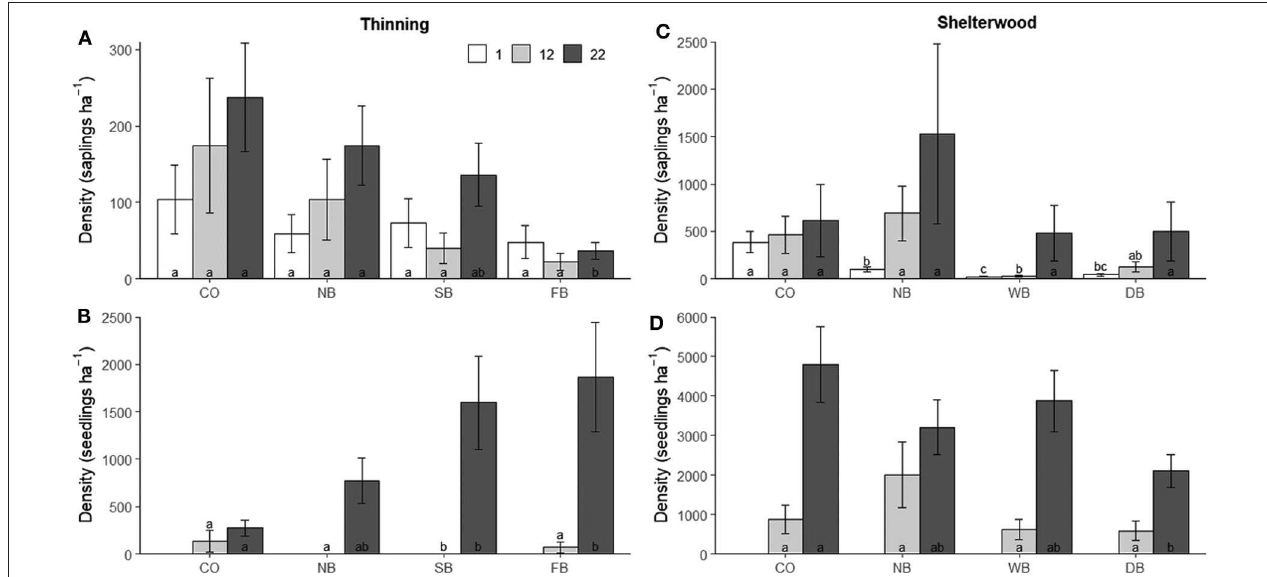
FIGURE 3 | Sapling and seedling density (mean and standard error) in 1993/94 (1 year post-treatment), 2005 (12 years post-treatment), and 2015 (22 years post-treatment) for (A,B) Thinning and (C,D) Retention Shelterwood. Treatments: CO = Control, NB = Cut, No Burn, SB = Cut + Spring Burn, FB = Cut + Fall Burn, WB = Cut + Wet Burn, and DB = Cut + Dry Burn. Saplings are ≥ 1.37m height and < 12.2cm DBH. Seedlings are < 1.37m height. Seedlings were not quantified in 1993/4. Different letters denote statistically different treatment values ( α = 0.05) within each time